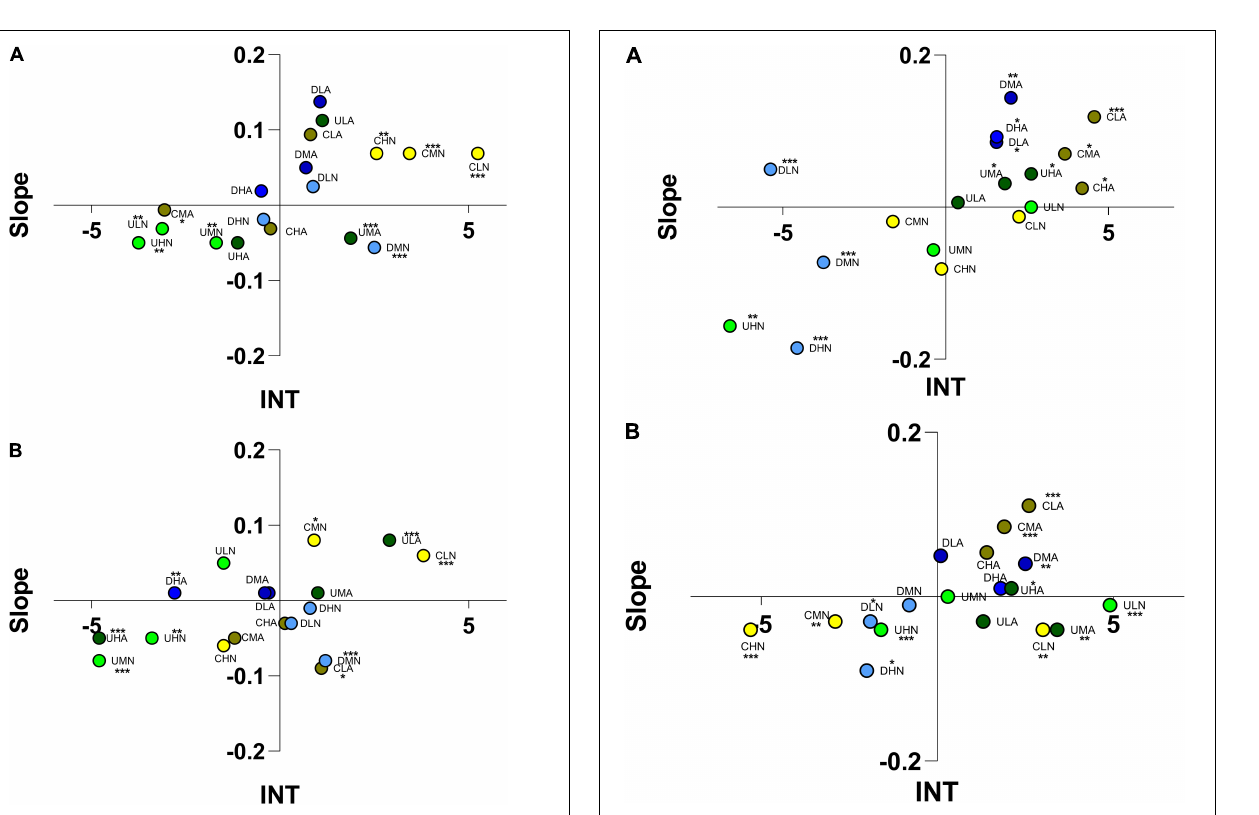
FIGURE 5 | Ordination into 1 of 4 sectors of Alvania lineata according to the scores reached for “Slope” and “INT” (integral time) in static arenas (A) and flow-through flumes (B) . The letters indicate the algae considered (C, Cocconeis scutellum var. parva ; D, Diploneis sp.; U, Ulva prolifera ), the concentration of VOCs (L, low; M, medium; H, high), and the culture and test conditions (N, normal conditions; A, acidified conditions). Asterisks indicate the significance of individuals’ position in the space.